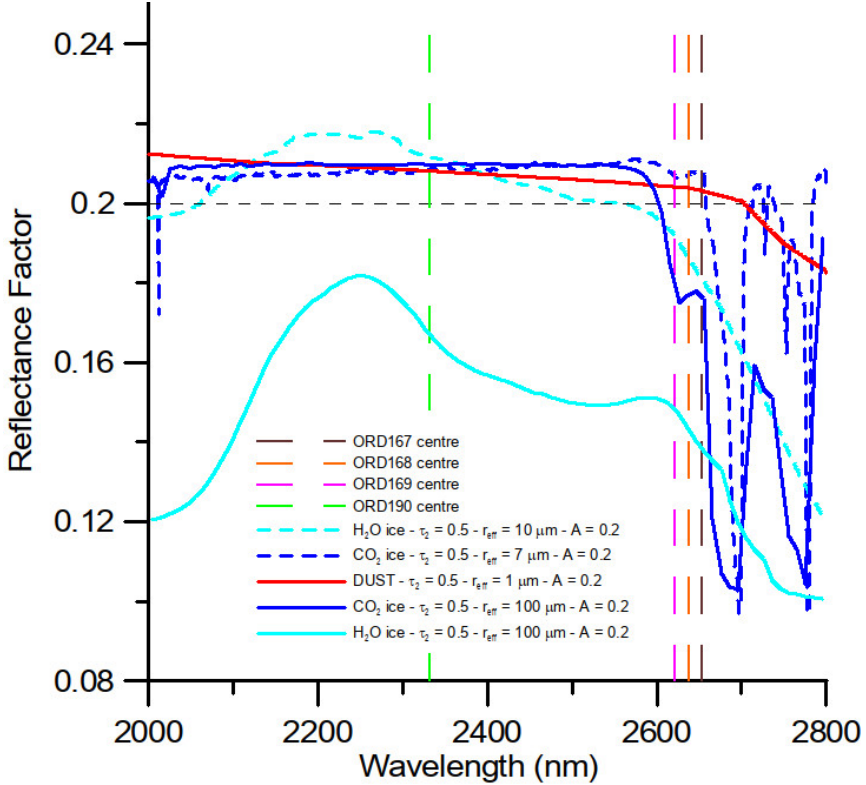
Figure 1. Simulated ice and dust spectra in the 2-2.8 µm range obtained by the MITRA tool [44–47]. The simulations have been performed with the following characteristics: a surface albedo of 0.2 (A = 0.2), an incidence angle of 0° ( i = 0°), and an optical depth at 2 µm of 0.5 (τ 2 = 0.5). We describe all aerosol layers by adopting lognormal size distributions with an effective variance of 0.1 (v eff = 0.1) and characteristic grain sizes (r eff ). Vertical dashed lines indicate the centres of orders. See the legend on the panel for the colour definition.